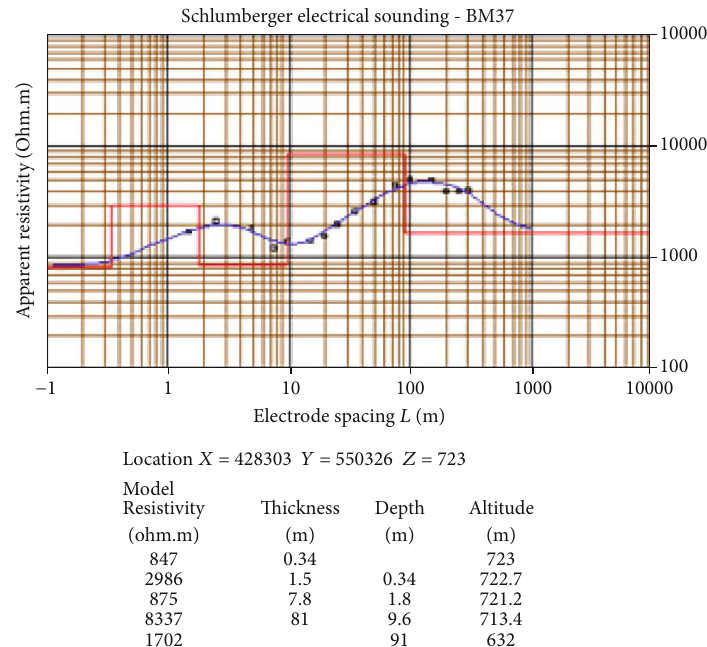
Figure 14: Sounding curve (BM